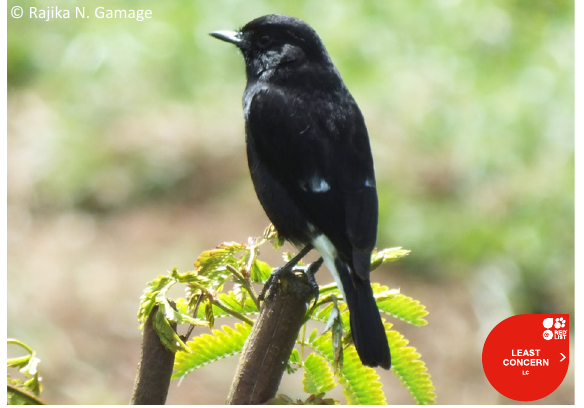
Image 11. Yellow-eared Bulbul Pycnonotus